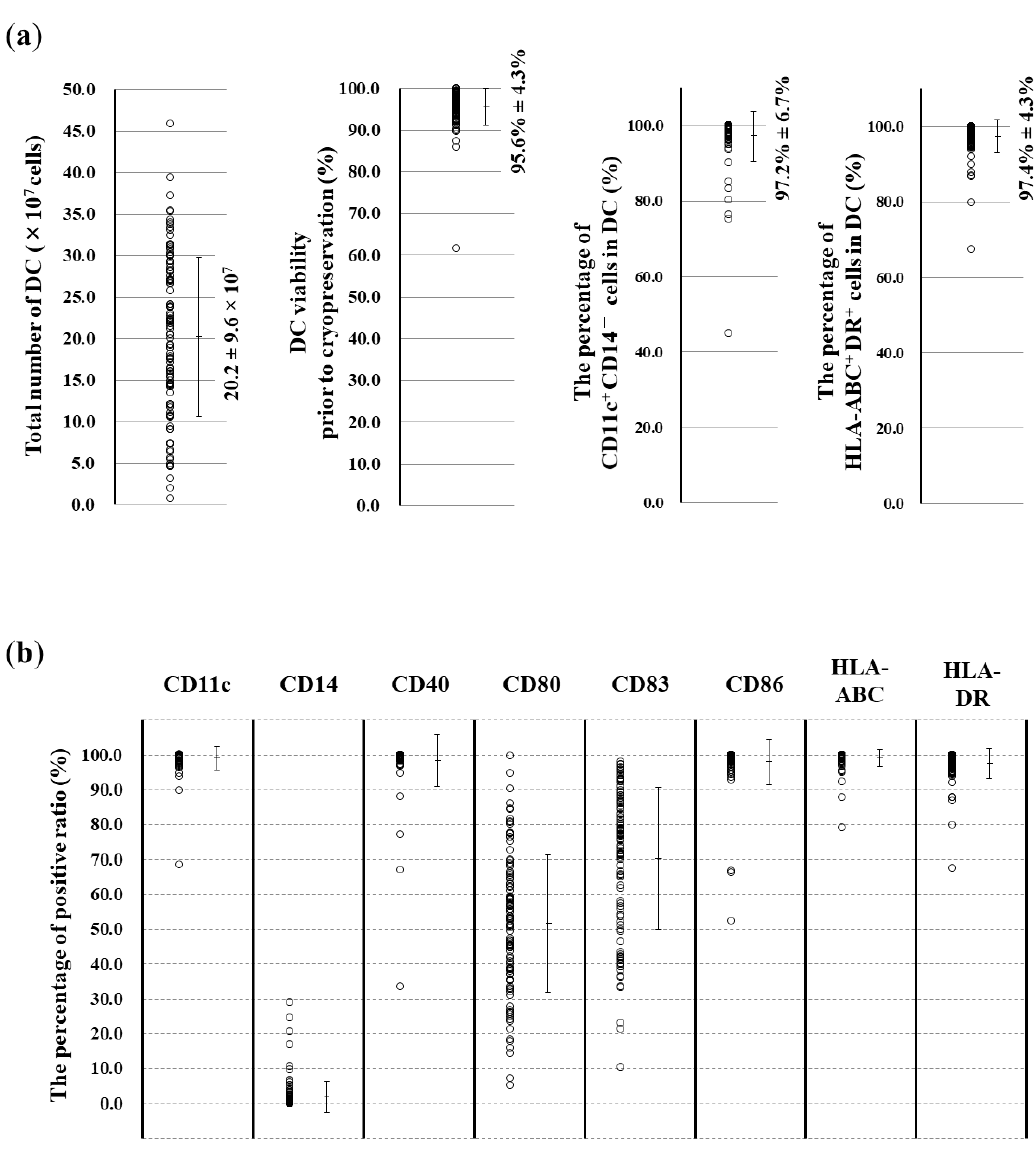
Figure 2. Analysis of the dendritic cell (DC) yield ( n = 108). ( a ) The number of DCs and the cell viability prior to cryopreservation was 20.2 ± 9.6 × 10 7 and 95.6% ± 4.3%, respectively. The percentages of the yielded DCs with the CD11c + CD14 − and human leucocyte antigen (HLA)-ABC + DR + phenotypes, representative of DCs, were 97.2% ± 6.7% and 97.4% ± 4.3%, respectively. Error bars on the dot plots represent the mean ± SD. ( b ) Single-color flow cytometric analysis of the mDCs (% of positive ratio): CD11c (99.0 ± 3.3); CD14 (1.9 ± 4.6); CD40 (98.3 ± 7.5); CD80 (51.6 ± 19.6); CD83 (70.3 ± 20.4); CD86 (98.0 ± 6.4); HLA-ABC (99.1 ± 2.6); and HLA-DR (97.8 ± 4.3). Mean positive ratios in the panels for CD11c, CD40, CD86, HLA-ABC, and HLA-DR were >90%. Error bars on the dot plots represent the mean ±